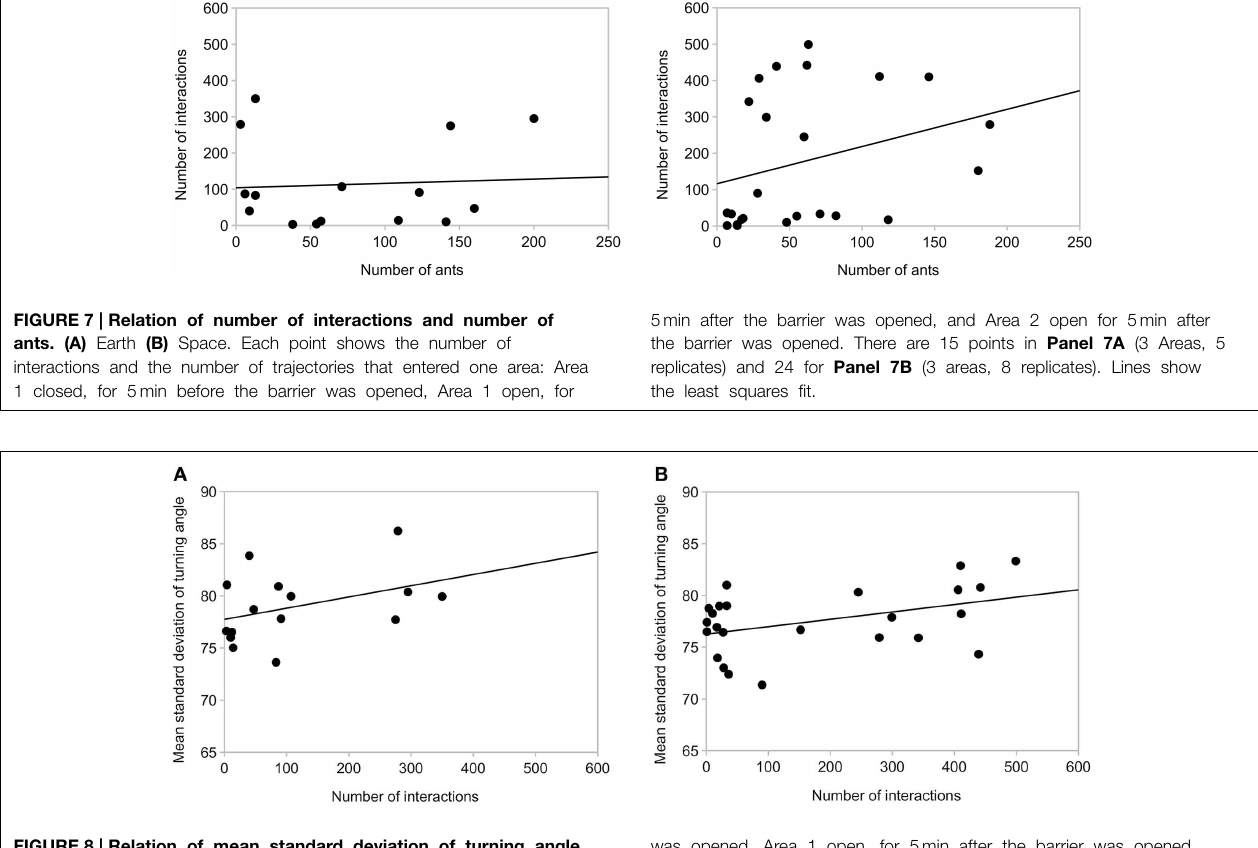
was opened, Area 1 open, for 5min after the barrier was opened, and Area 2 open for 5min after the barrier was opened. There are 15 points in Figure 7A (3 Areas, 5 replicates) and 24 for Figure 7B (3 areas, 8 replicates). Lines show the least squares fit.